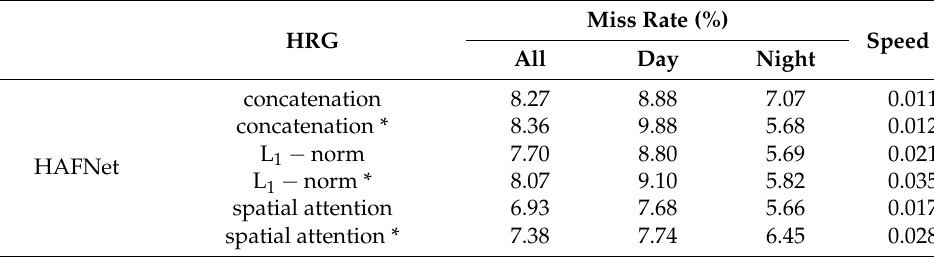
Table 6. Ablation on the hierarchical reference generation (HRG) module.